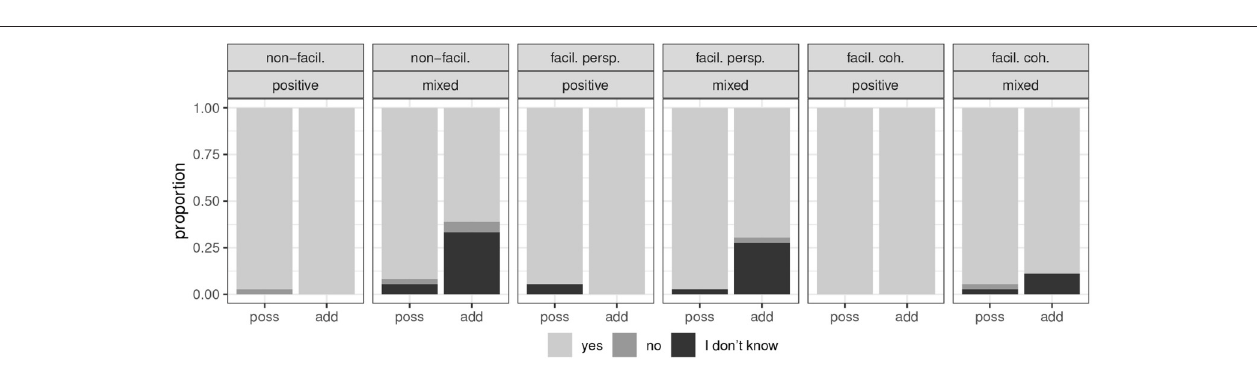
FIGURE 5 | Question proportion results of experiment 1, split by discourse